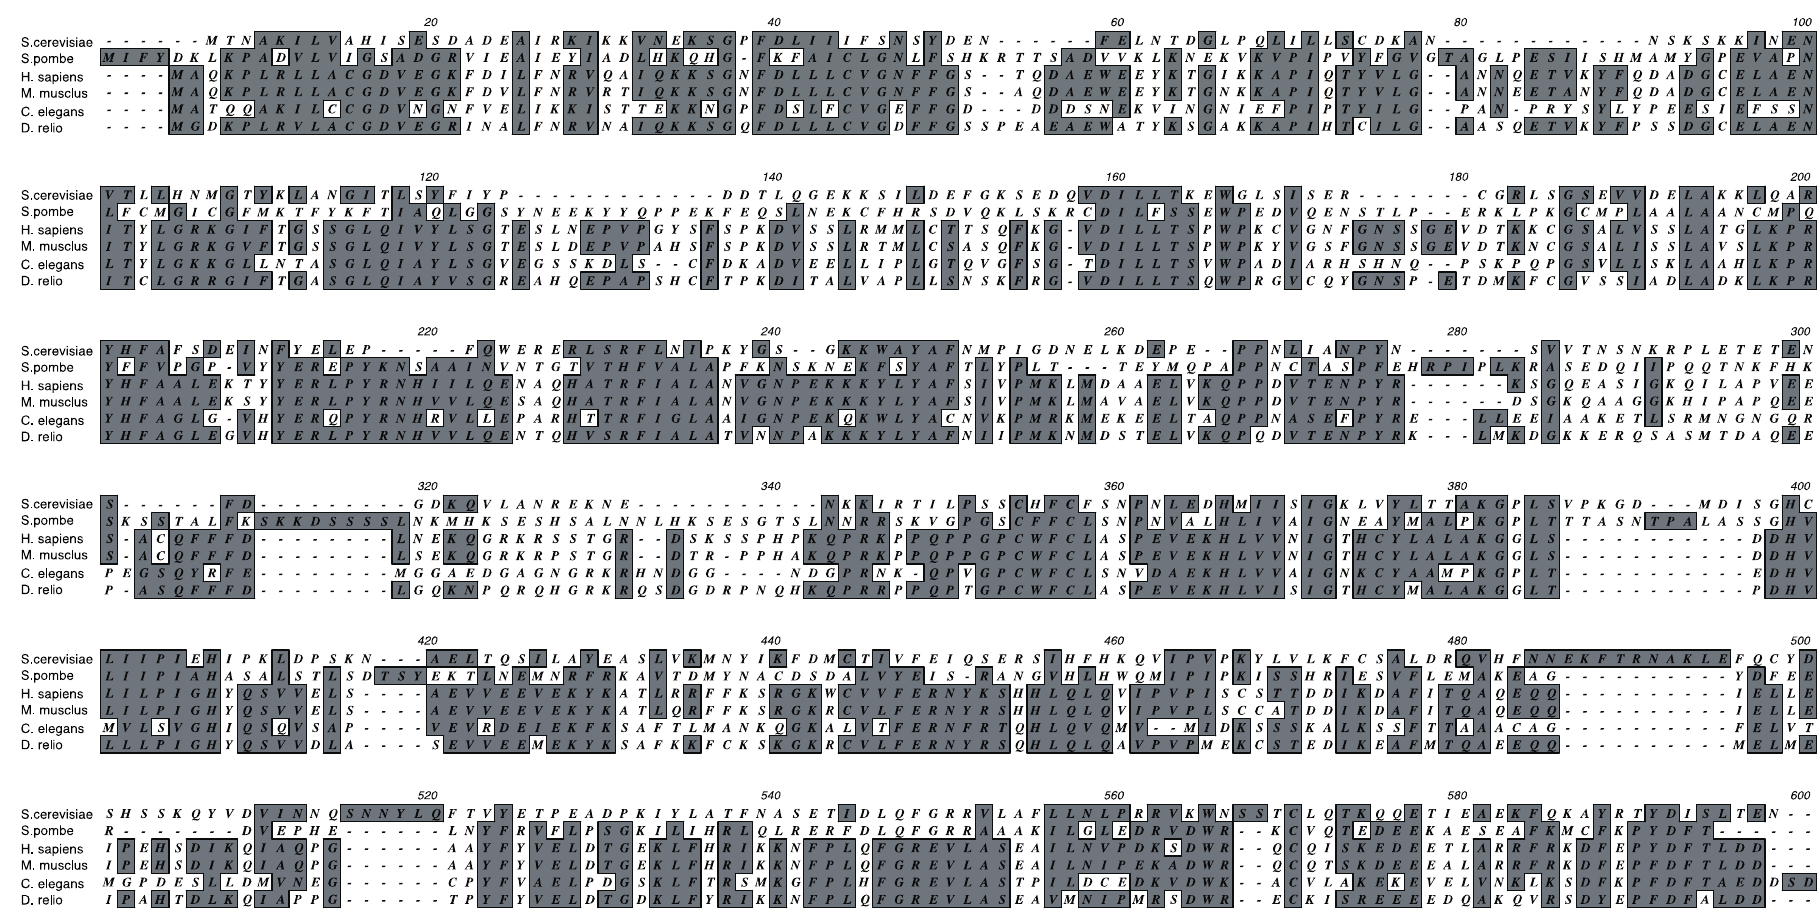
Figure 3. Amino acid sequence alignment of Drn1 proteins from various organisms. Drn1 proteins from Saccharomyces cerevisiae (NP_011607.3), Schizosaccharomyces pombe (NP_593012.1), Homo sapiens (NP_060764.3), Mus musculus (NP_001074546.1), Caenorhabditis elegans (NP_504577.1) and Danio rerio (NP_001038223.1) were aligned using the ClustalW alignment program (http://www.genome.jp/tools/clustalw/). Identical and similar residues are indicated by dark